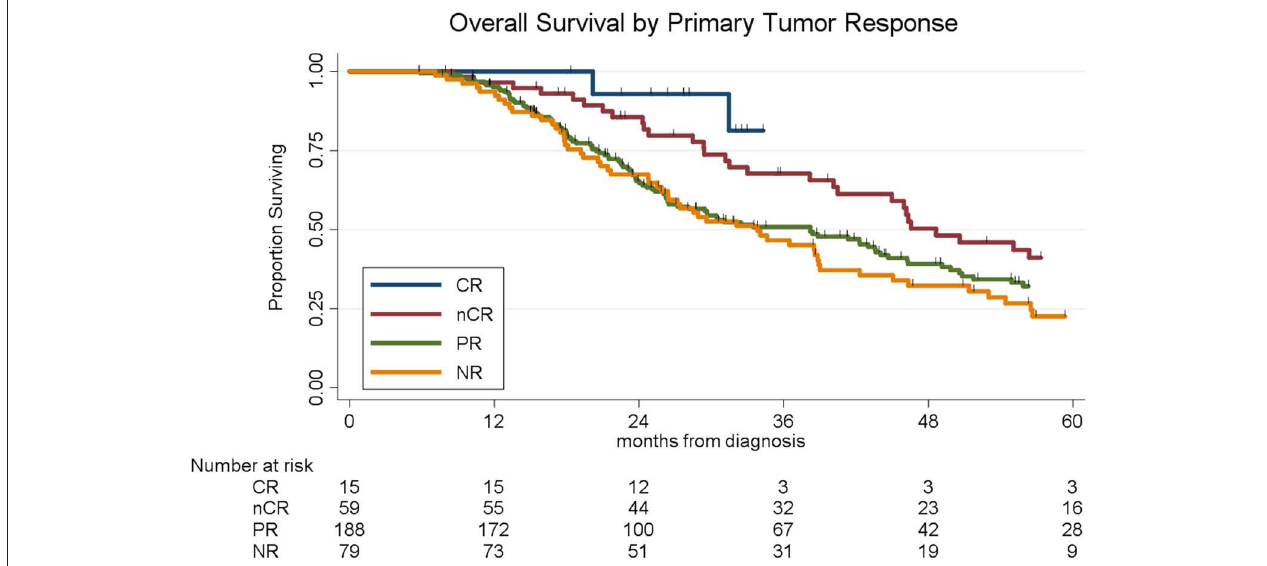
FIGURE 1 | Overall survival by histopathologic response of the primary tumor.